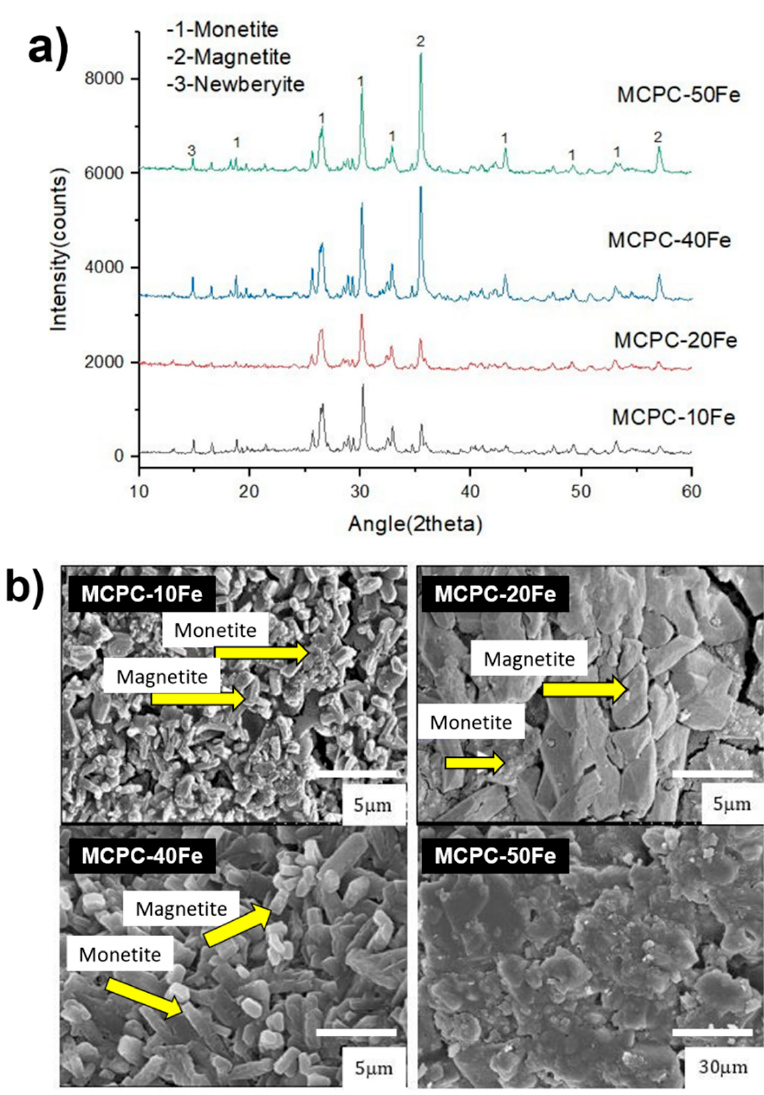
Figure 1. ( a ) X-ray diffraction analysis and ( b ) Scanning electron microscopy (SEM) images of MCPC-10 Fe, MCPC-20, Fe MCPC-40, and Fe MCPC-50 Fe. MCPC indicates magnetic calcium phosphate cement, and Fe indicates magnetite incorporation.